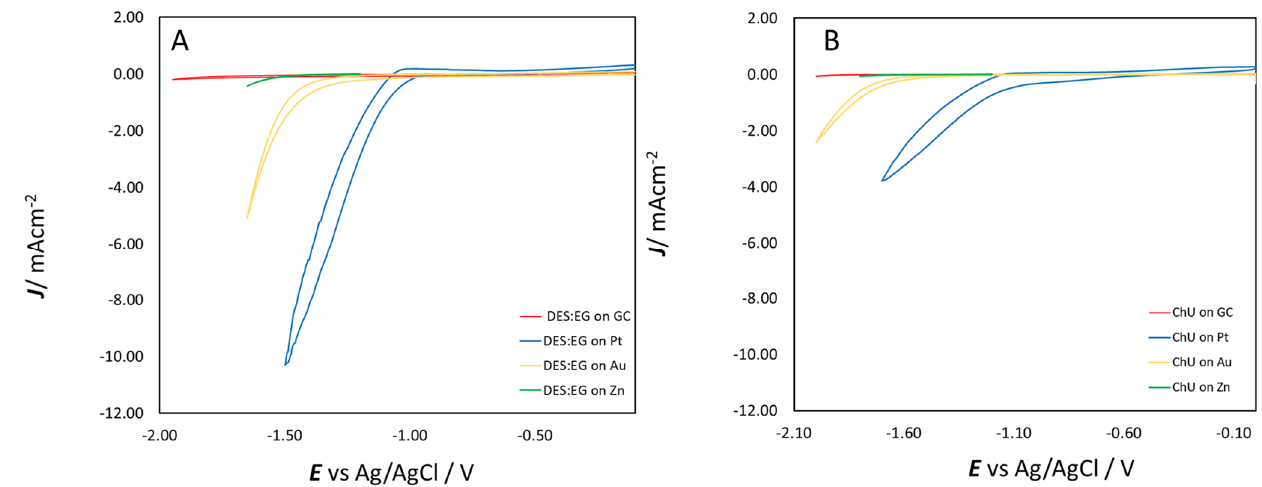
Figure 1. Cyclic voltammograms in the cathodic range for ChEG (Panel ( A )) and ChU (Panel ( B )) with GC, Pt, Au and Zn electrodes.